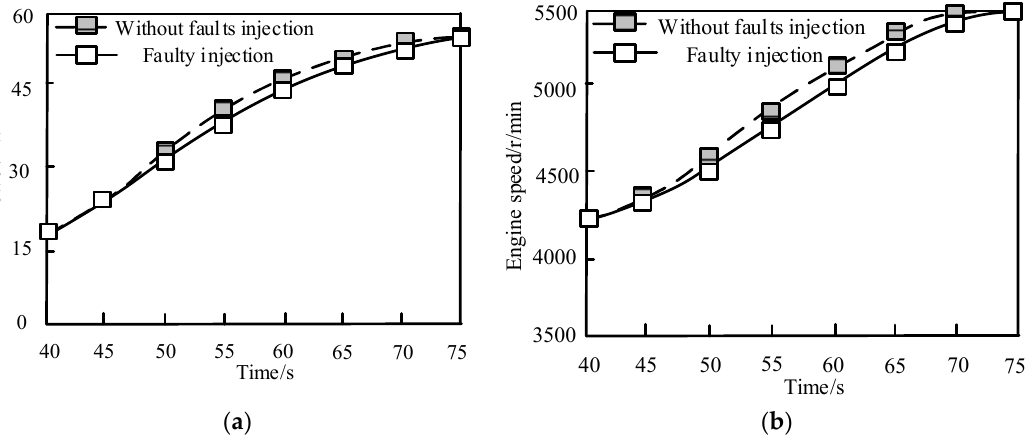
Figure 10. Changes in engine power and speed over time in experimental vehicle models with and without fault injection. ( a ) Engine power changes; ( b ) Engine speed changes. The real-time diagnosis and alarm results for engine running faults in the experimental vehicle model are shown in Figure 11.